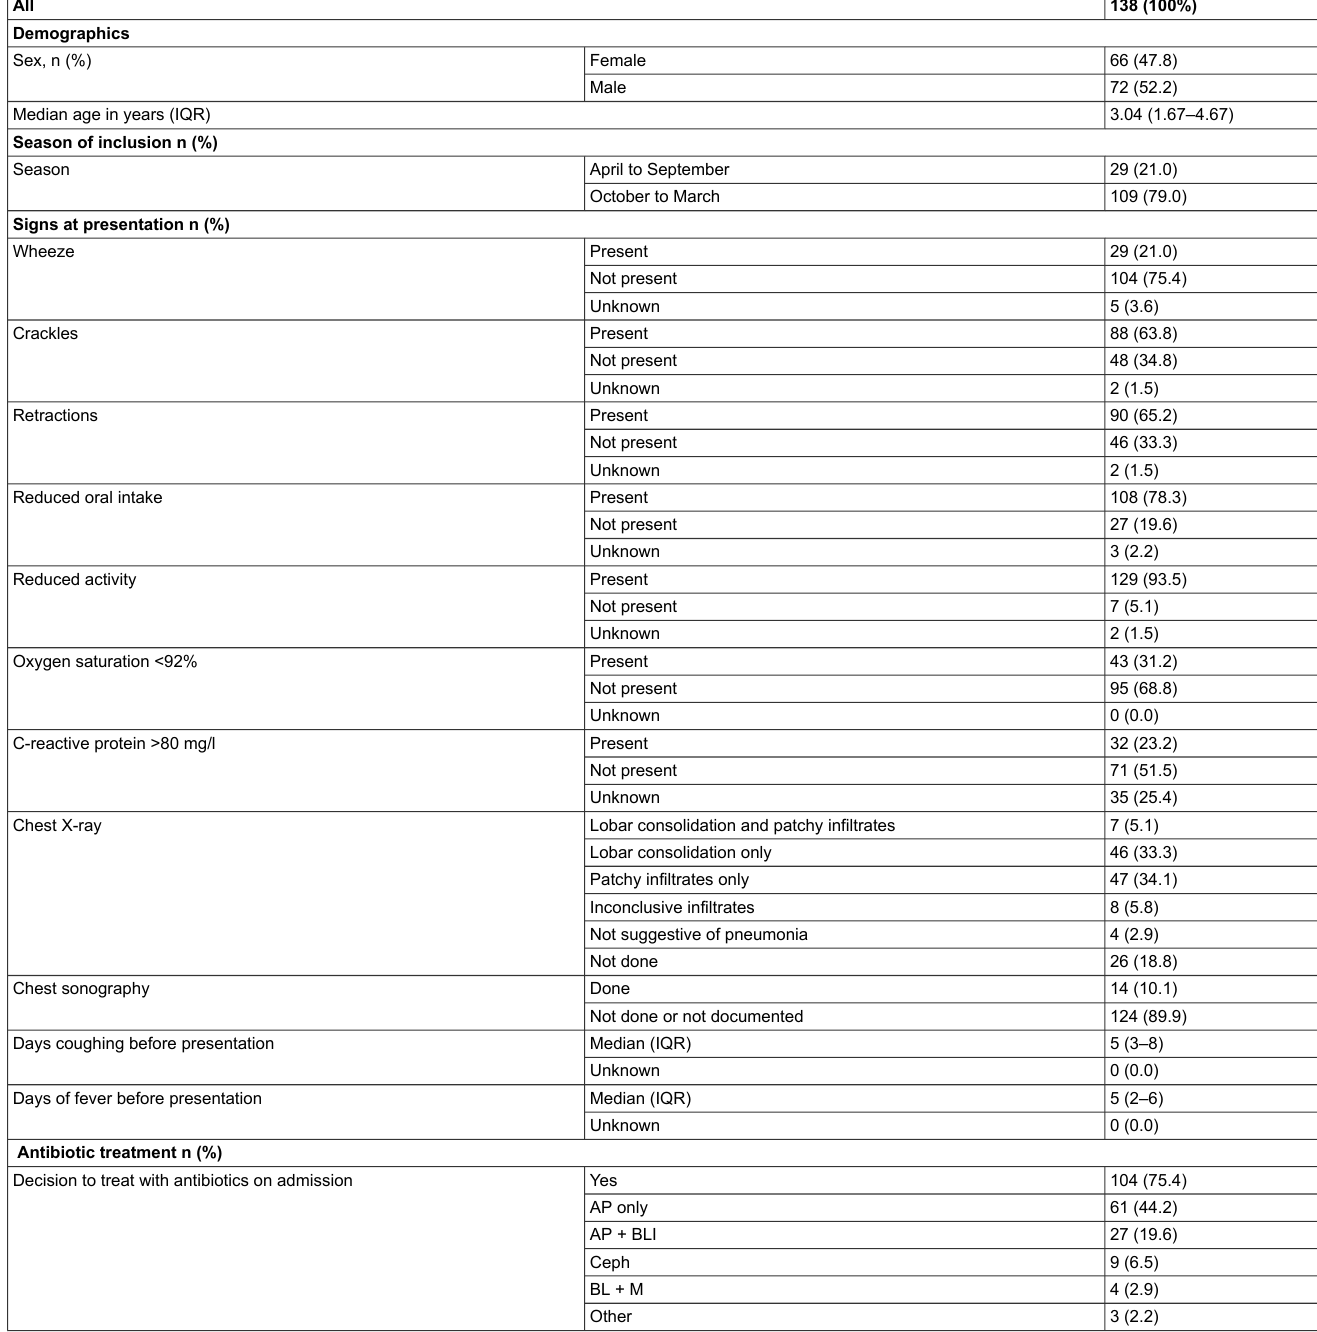
Table 2: Clinical characteristics at presentation and antibiotic